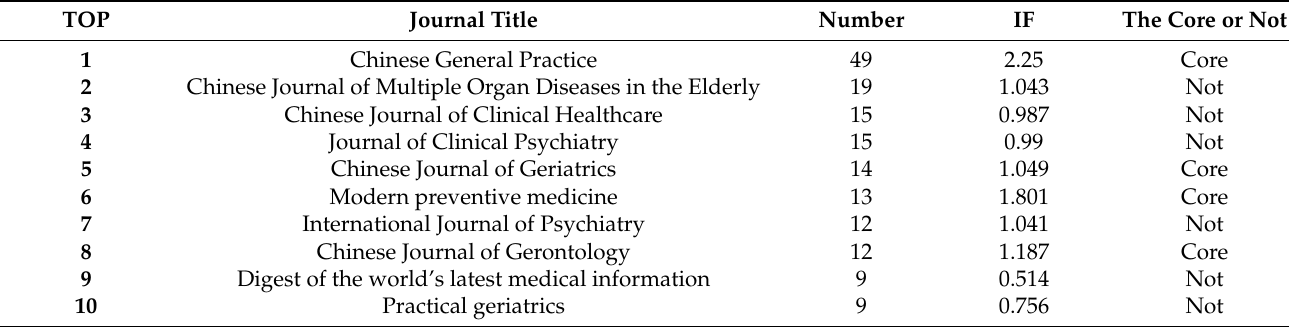
Table 1. Top 10 English Journals Contributing.